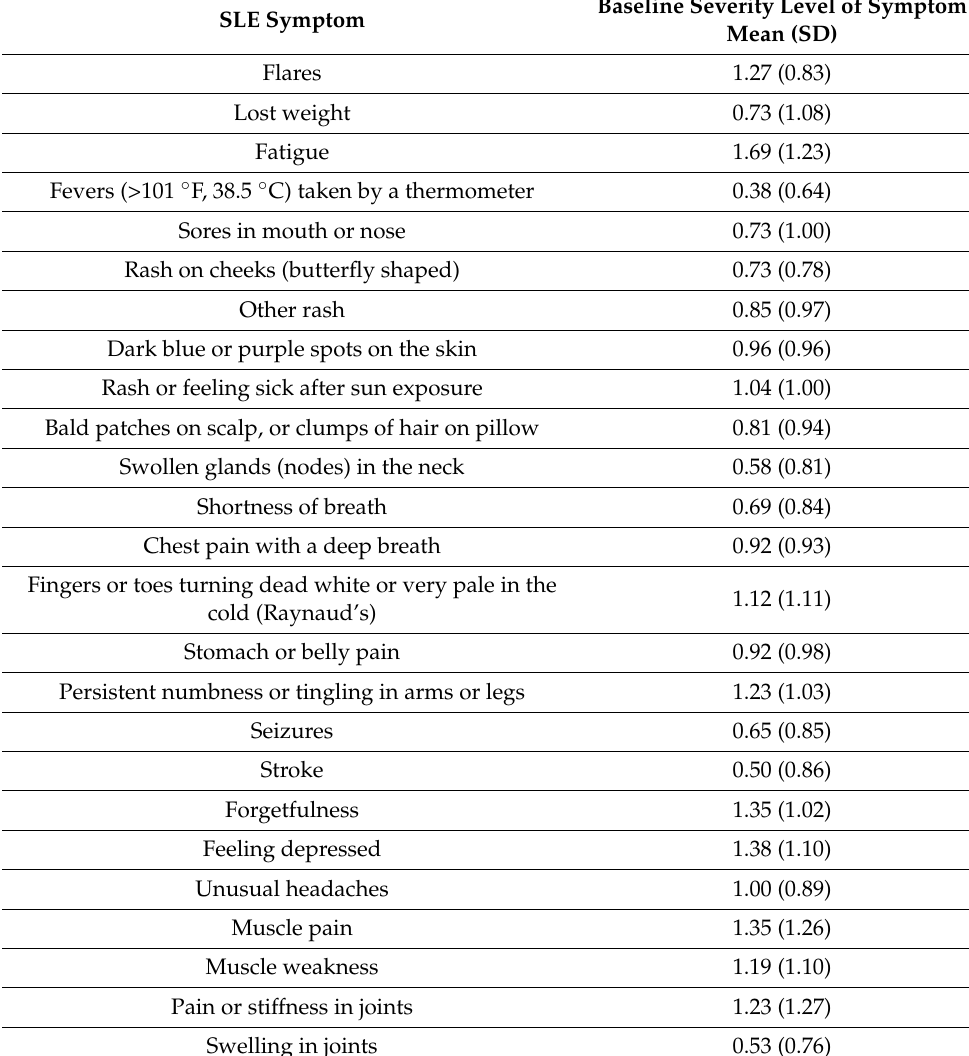
Table 2. Baseline SLE Symptoms according to the SLAQ (on a Likert scale of 0 (no problem) to 3